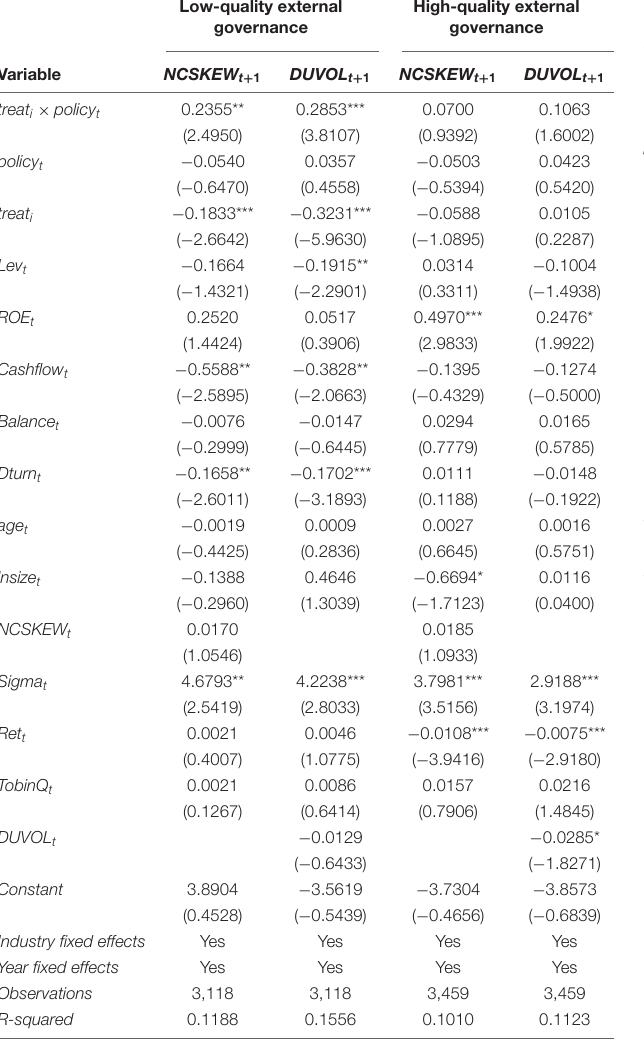
TABLE 7 | Impact of external corporate